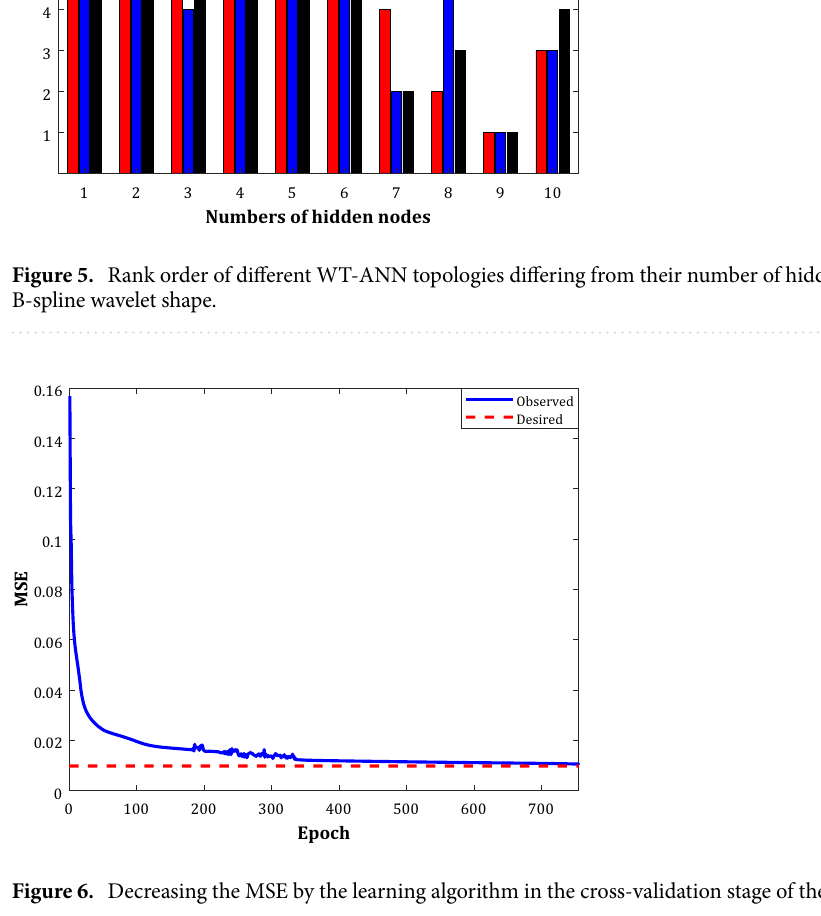
Figure 6. Decreasing the MSE by the learning algorithm in the cross-validation stage of the